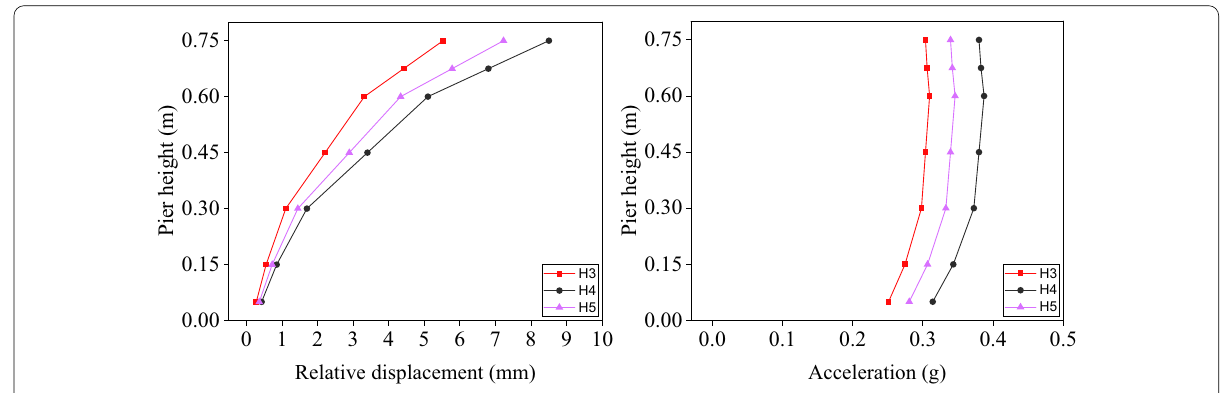
Fig. 12 Peak relative displacement and peak acceleration of the pier under structure orientation ( 90